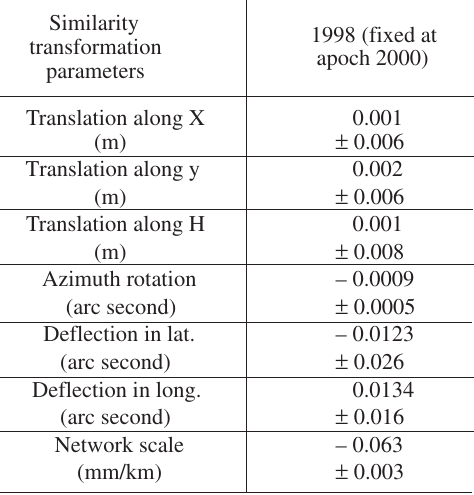
Table VI. Transformation parameters for 1998 net- work adjustment, fixed at epoch 2000. Similarity